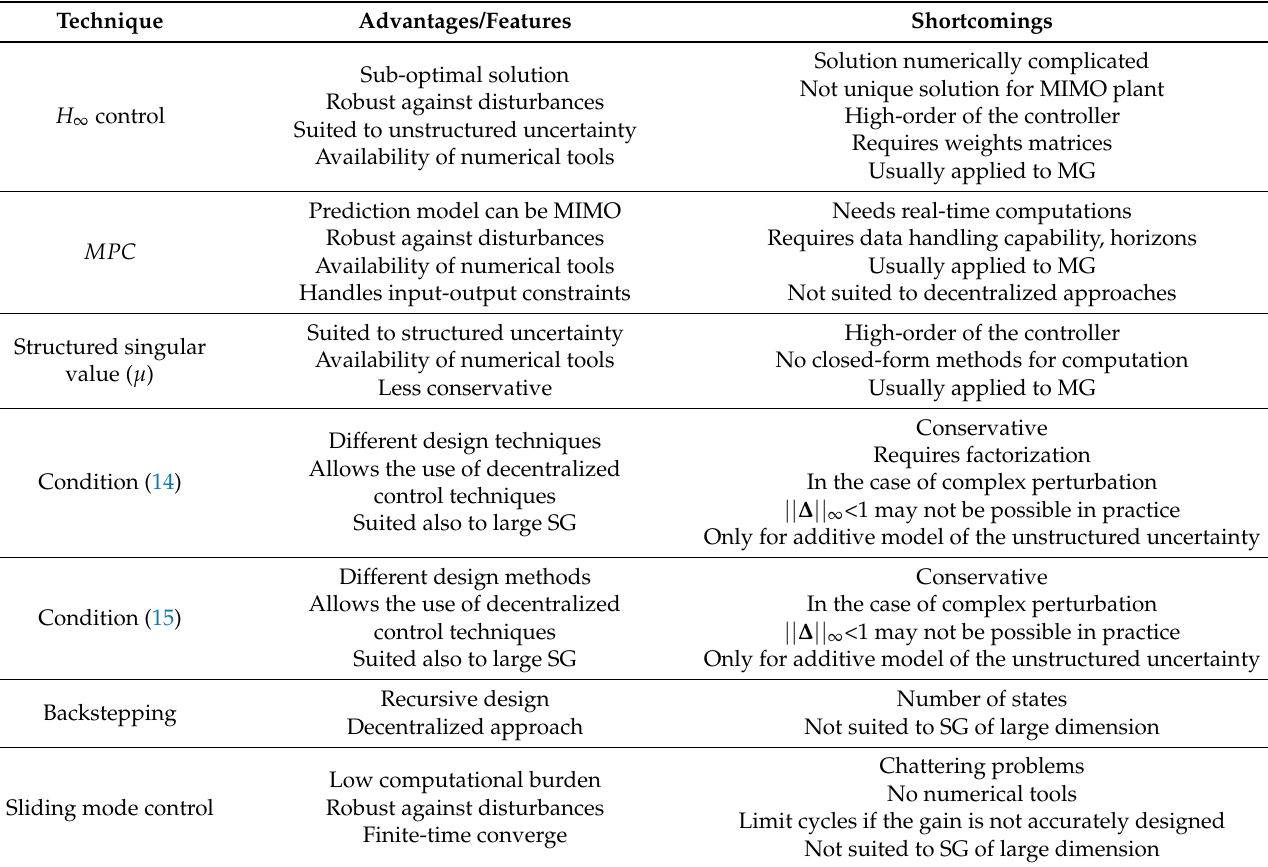
Table 1. Evaluation of the described